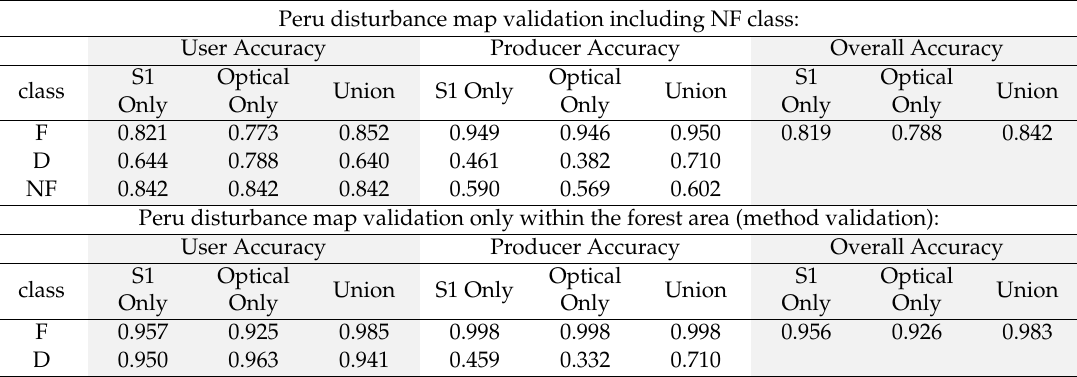
Table 5. Disturbance map validation for Peru.